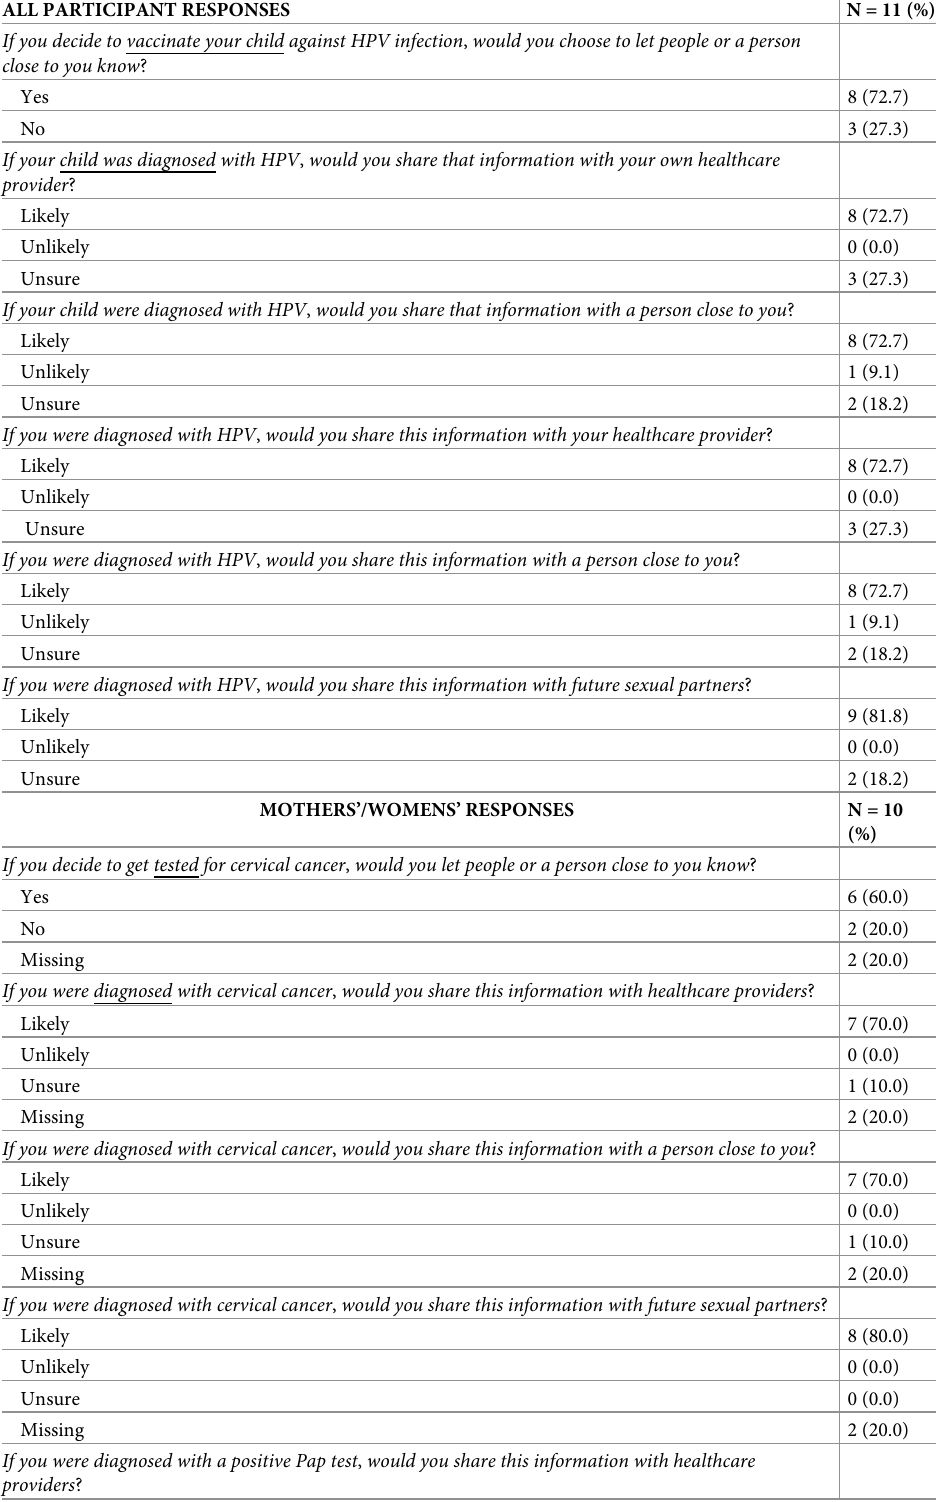
Table 3. Disclosure related to cervical cancer prevention